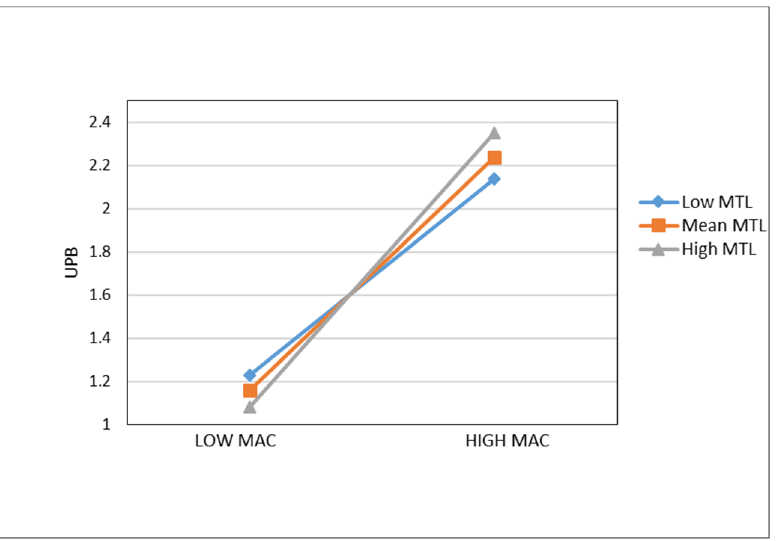
Figure 3. The Moderating role of MTL on the relationship between MAC and UPB. Note: UPB = Unethical Pro-organizational Behavior; MAC = Machiavellianism; MTL = Motivation to Learn.